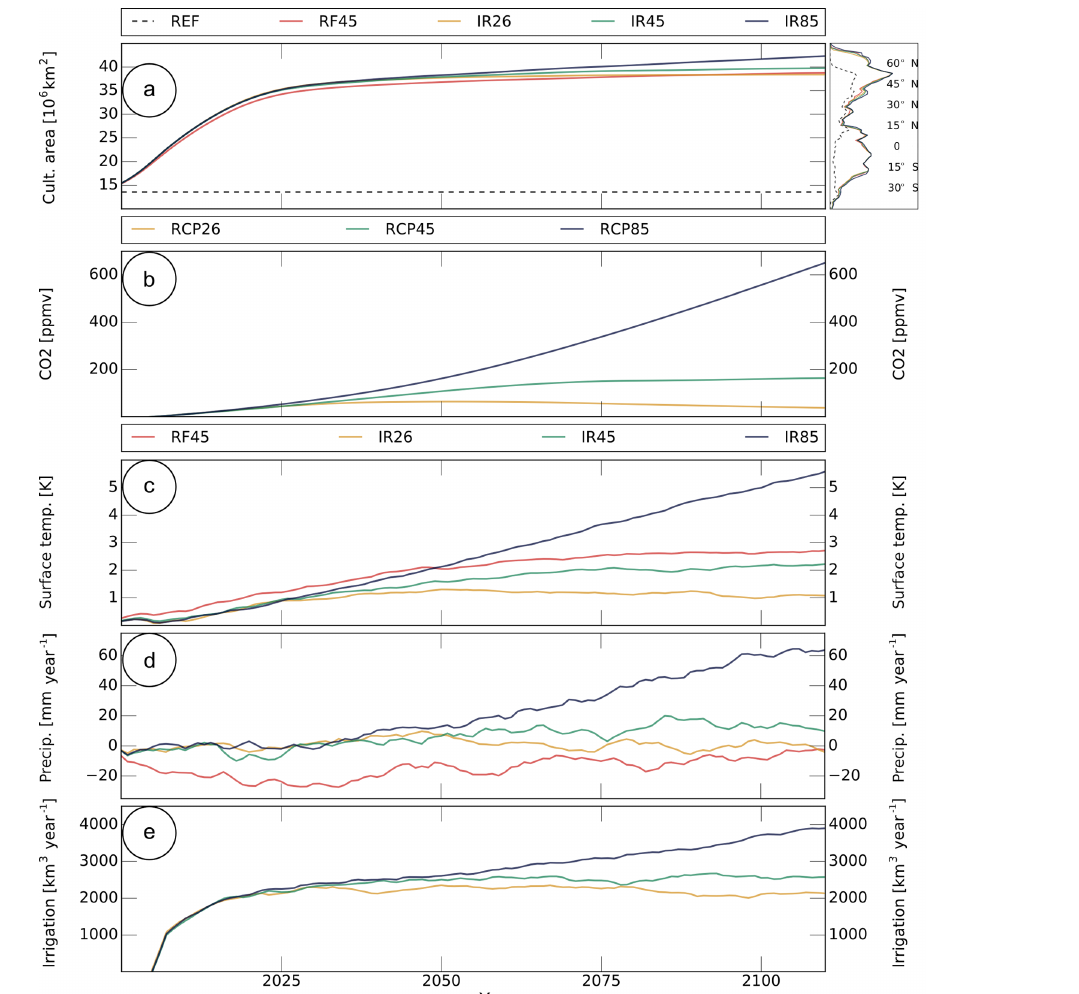
Figure 3. Cultivated area and global mean climate. (a) 10-year running mean of the global extent of cultivated areas. The panel on the right shows the zonal distribution of cultivated areas in 2100 (2085–2114 mean). (b) The increase in atmospheric CO 2 for the three GHG scenarios. For the land surface, (c–e) the differences to present-day climate (REF): (c) temperature, (d) precipitation and (e) accumulated